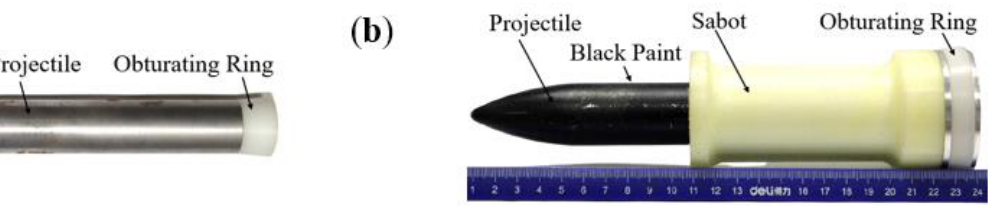
Table 3. Steel composition for 30CrMnSiNi2A. Figure 2. Test projectile: ( a ) 30 mm smoothbore gun test projectile; ( b ) 60 mm smoothbore gun test projectile.